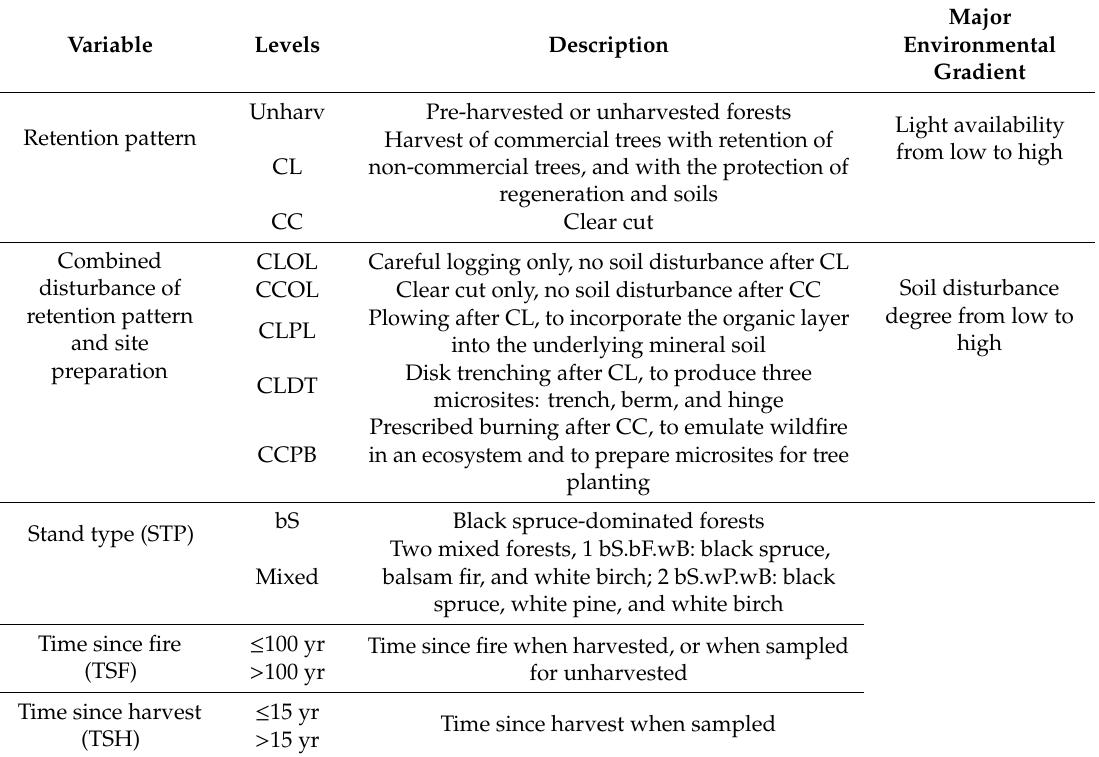
Table 2. Ecological variables used in the